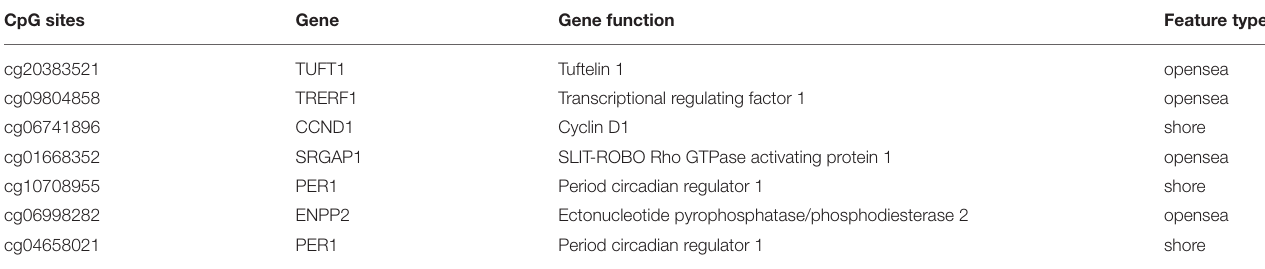
TABLE 2 | The 7 DMSs for BRCA